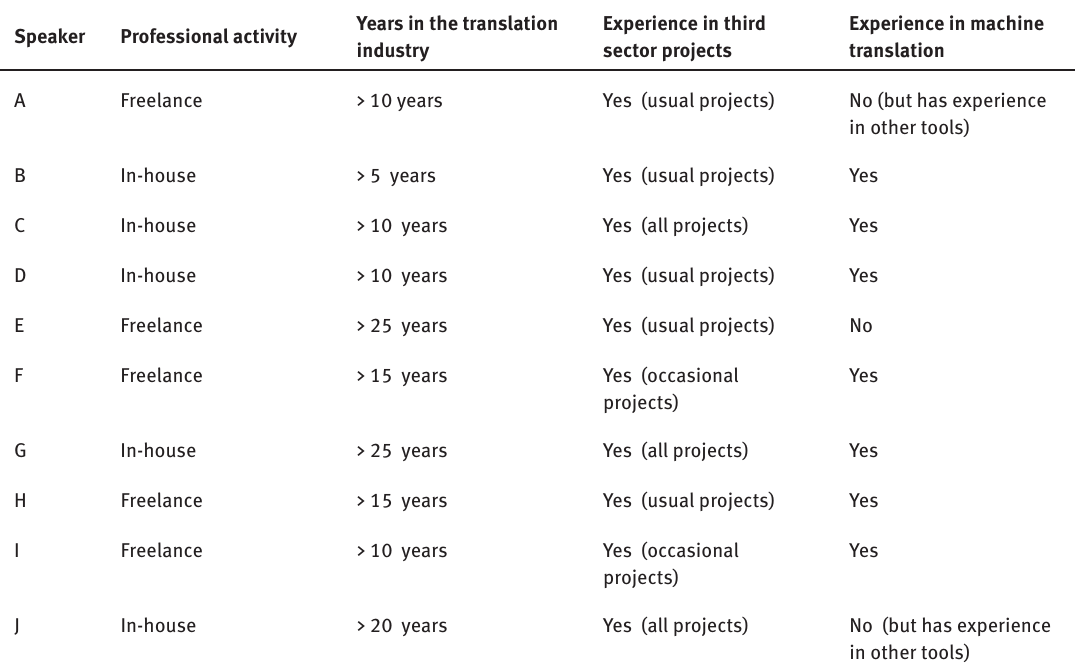
Table 1: Profile of the translators who participated in the study